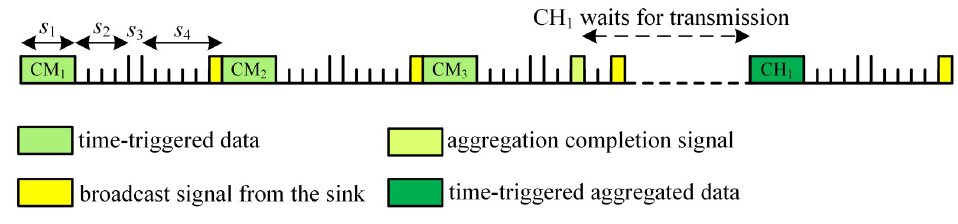
Fig 4. Transmission schedule of serving time-triggered traffic.